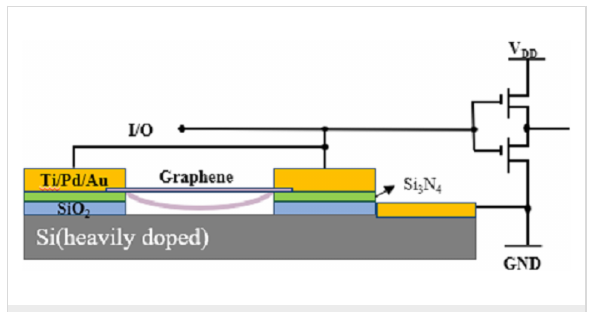
Figure 7: NEM switch used for ESD. Figure 7 was redrawn from [61].